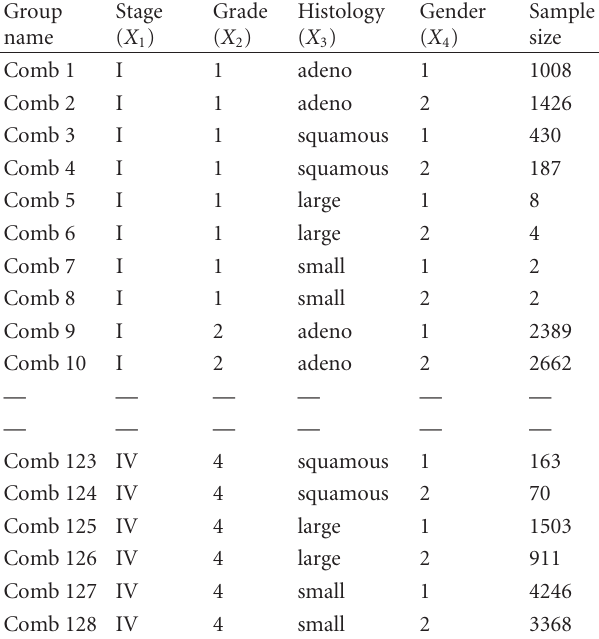
Table 1: Lung cancer data of 90,214 patients. Survival time is measured in months. Here, adeno, squamous, large, and small represent adenocarcinoma, squamous cell carcinoma, large cell carcinoma, and small cell carcinoma, respectively.